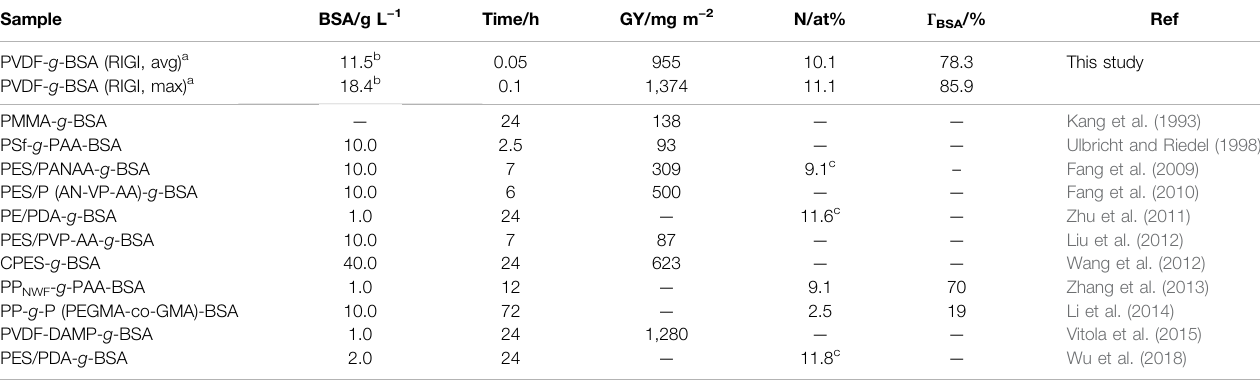
TABLE 8 | Comparison of grafting yields for immobilization of BSA on different polymers. In case of multiple reported data, highest yields were noted. Given are the applied BSAmassconcentration,thereactiontime(forRIGI:impregnationtime),aswellasthreekindsofgraftingyieldparameters.Pleasenote,literatureGYdatawasconverted from μ g cm − 2 to mg m − 2 to faciliate comparison (conversion factor: 10).